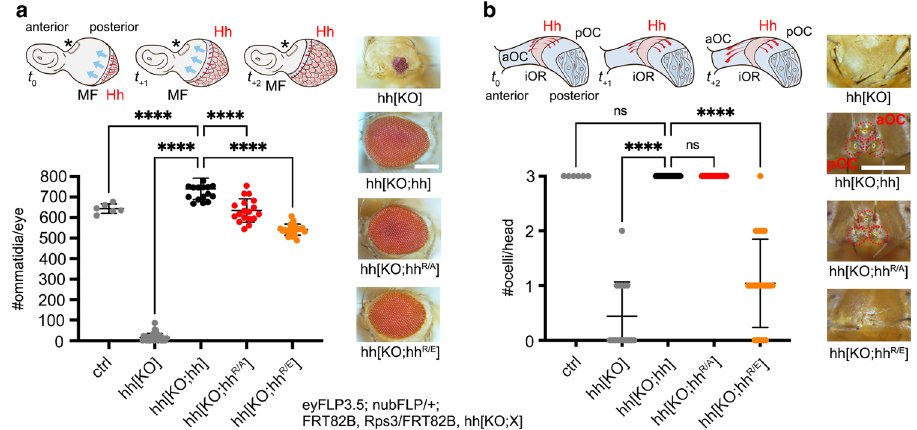
Fig.3|Eye-disc-speci fi chhvariantexpressionfromclonesinmovingandstatic sources. a The cartoon shows reiterated cell-to-cell Hh signaling from a clonal source (Supplementary Fig. 5) moving at a particular pace to drive photoreceptor differentiation across the eye primordium. Red arrows denote Hh spread, blue arrows denote the movement of the morphogenetic furrow (MF), t 0 -t +2 indicates early and later stages. The asterisk and dashed area indicate the ocellar fi eld (as schematically shown in b ). Clones homozygous for hh[KO] do not express hh , which severely impairs eye development, but hh or hh variant cDNA expression from both alleles restores eye development. Scale bar: 100 μ m. Despite the